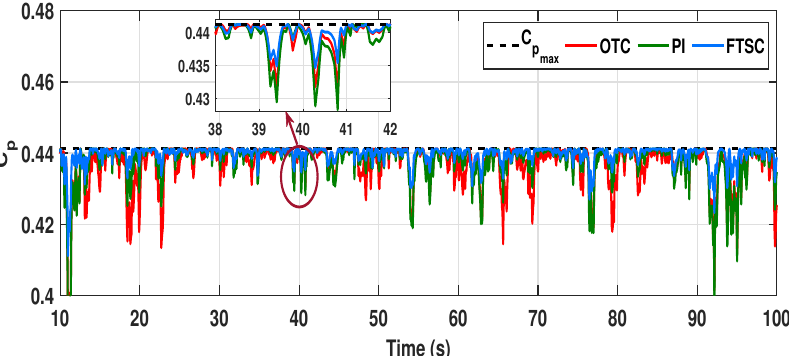
Figure 14. Power coefficient ( C p ) comparison of different control schemes under varying wind profile case-I .